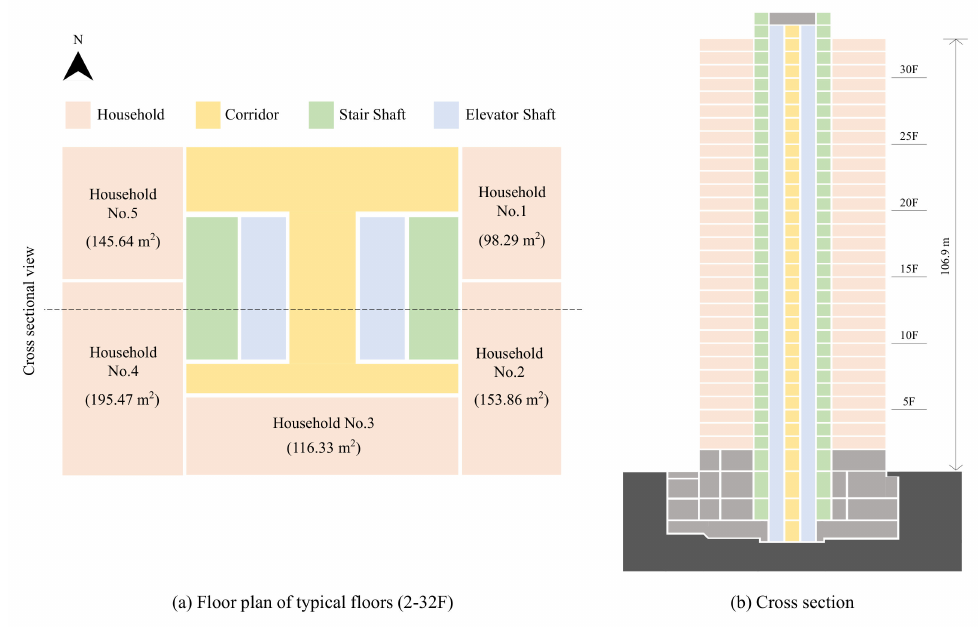
Figure 3. Floor plan and cross section of the target building